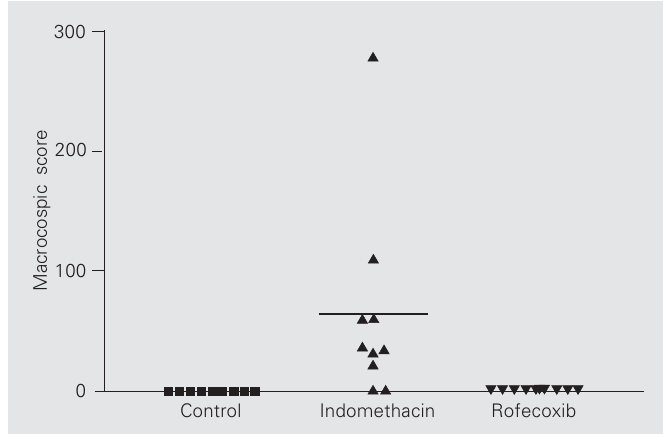
Figure 1. Scatter diagram showing individual and mean intestinal macroscopic scores for control rats (N = 10) and rats treated by gavage with a single dose of 7.5 mg/kg indomethacin (N = 10) and 2.5 mg/kg rofecoxib (N = 10). The horizontal line is the mean. P < 0.05 for control vs indomethacin and rofecoxib vs indomethacin. Statistical differences in macroscopic scores among groups were assessed by one-way analysis of variance and Bonferroni’s multiple comparison